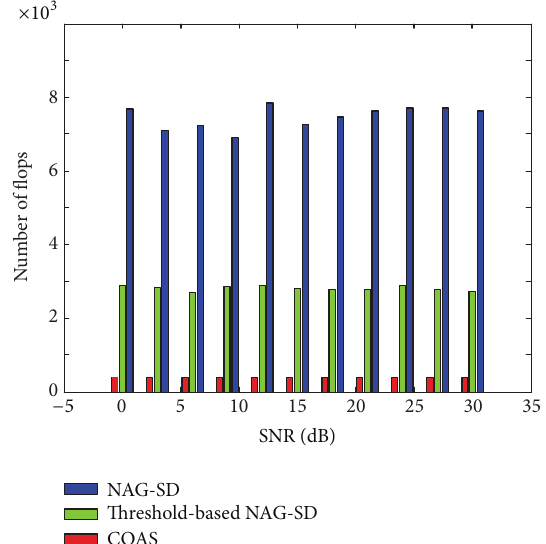
Figure 4: Computational complexity comparison of different TAS schemes in